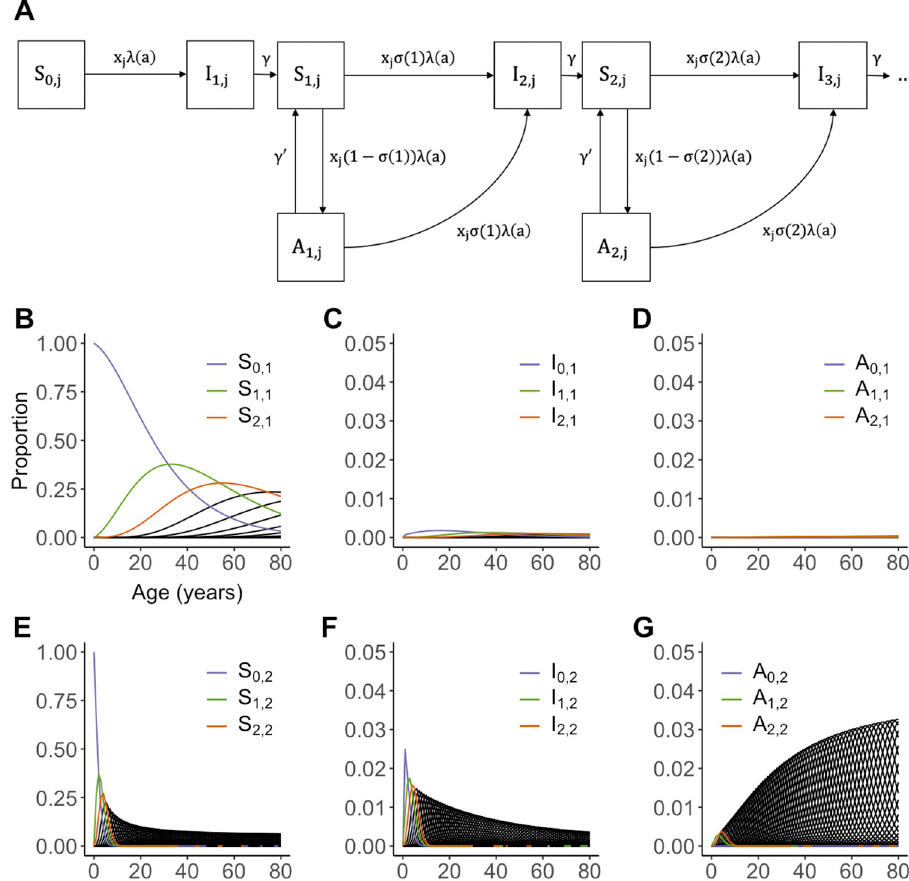
Fig 3. Transmission dynamics of Plasmodium vivax in a heterogeneous population. ( A ) SIS-type model used to describe the dynamics of symptomatic and asymptomatic Plasmodium vivax infections across age groups in LR and HR individuals. Compartment S represents susceptible but uninfected individuals from risk group j who have i , j experienced i prior clinical malaria. At birth, individuals are allocated to compartment S 0, j . Compartment I i , j represents individuals from risk group j currently experiencing their i th clinical vivax malaria episode Finally, compartment A i , j represents individuals from risk group j with i past clinical malaria episodes who are currently experiencing an asymptomatic P . vivax infection. The next panels show the dynamics of the following: ( B ) Susceptible but uninfected LR individuals; ( C ) Infected and symptomatic LR individuals; ( D ) Infected and asymptomatic LR individuals; ( E ) Susceptible but uninfected HR individuals; ( F ) Infected and symptomatic HR individuals; and ( F ) Infected and asymptomatic HR individuals. Redrawn from [68]. HR AU : AnabbreviationlisthasbeencompiledforthoseusedinFig 3 : Pleaseverifythatallentriesarecorrect : , high-risk; LR, low-risk; SIS, susceptible-infected-susceptible. during mosquito bites and relapses arising from reactivating hypnozoites. The best-fitting model suggests that 20% of the population is under high-risk and, assuming that asymptomatic infec- tions last 90 days on average (i.e., γ 0 . = 1/90 per day), this group is estimated to contribute 86% of the overall vivax malaria burden. The model also suggests that as many as 25 symptomatic P . vivax infections per individual, on average, are required to reduce the probability of developing clinical malaria risk by half [68]. Some people essentially from the HR group experience enough infections during their childhood and adolescence to acquire clinical immunity as young adults and eventually constitute the asymptomatic parasite reservoir. Individuals assigned to the low-risk group contribute very little to the overall burden of infection and disease. In addition to acquired immunity, differences in parasite virulence might also account for the high proportion of asymptomatic infections at times of low transmission [70]. Virulent